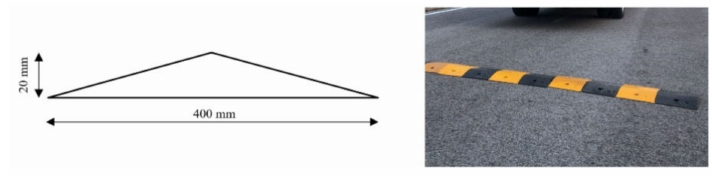
Figure 2. Speed bump used in the